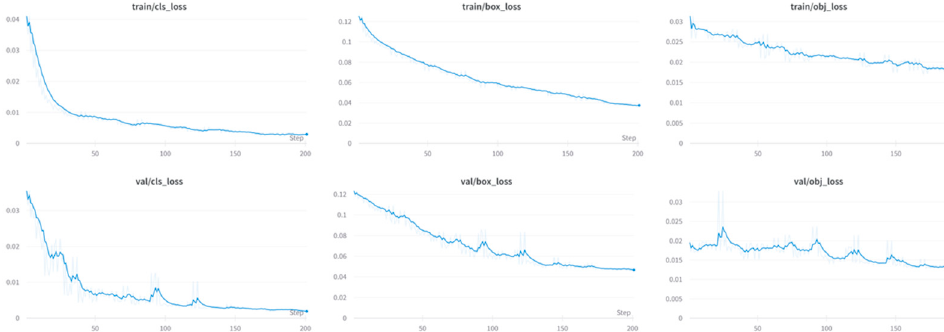
Figure 6. Train and validation loss.